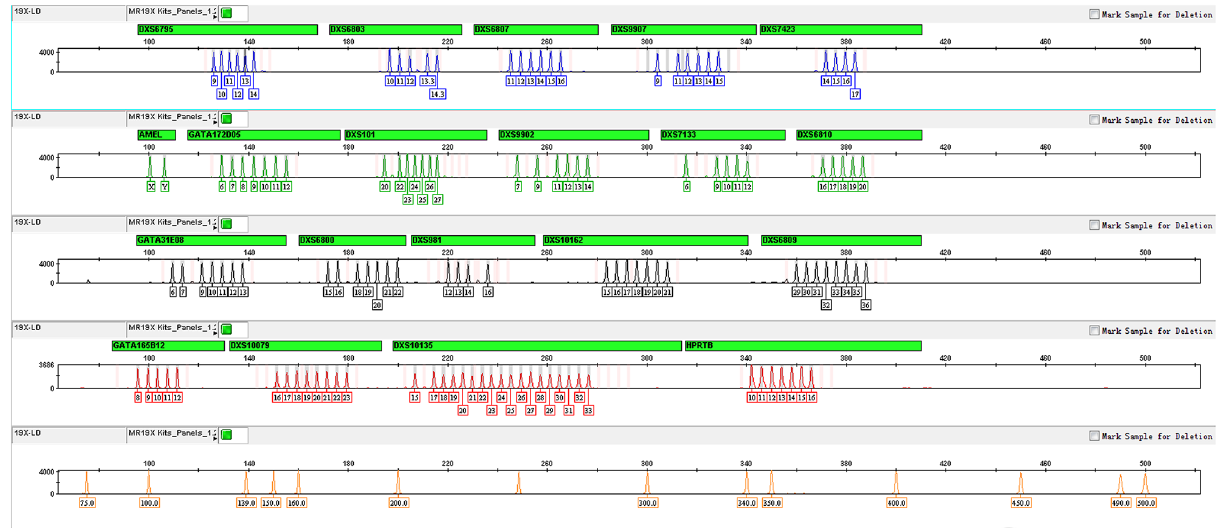
Figure 1. Electropherograms of allelic ladders and the internal size standards designed for the multiplex system. The four allelic ladders panels (from top to bottom) represent the FAM (blue), HEX (green), TAMRA (yellow), ROX (red) dye-labeled peaks with allele numbers underneath each peak. The fifth panel shows internal size standards labeled with Orange500 dye (75, 100, 139, 150, 160, 200, 250, 300, 340, 350, 400, 450, 490, and 500